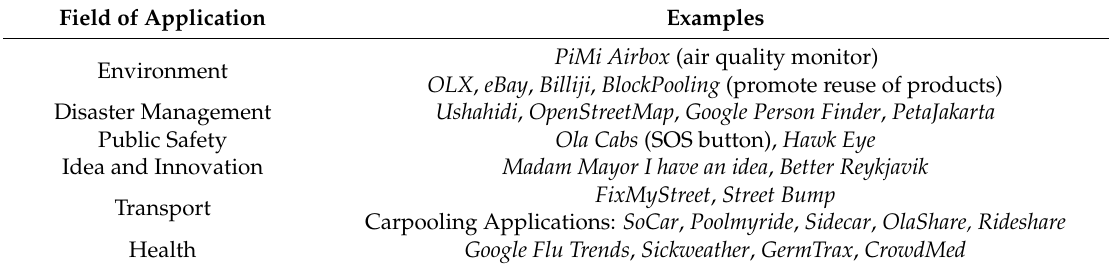
Table 1. Examples of popular crowdsourcing platforms according to fields of their